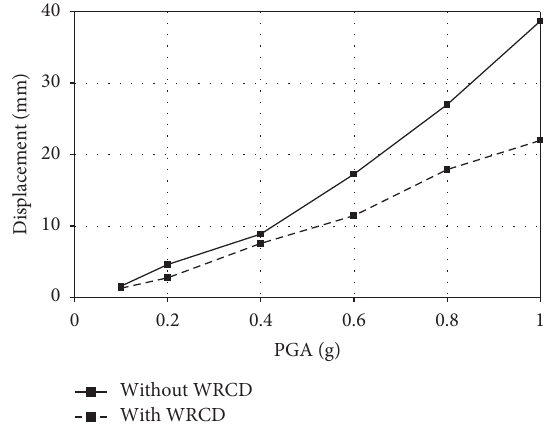
Figure 13: Te maximum displacement of 2# fxed pier top.